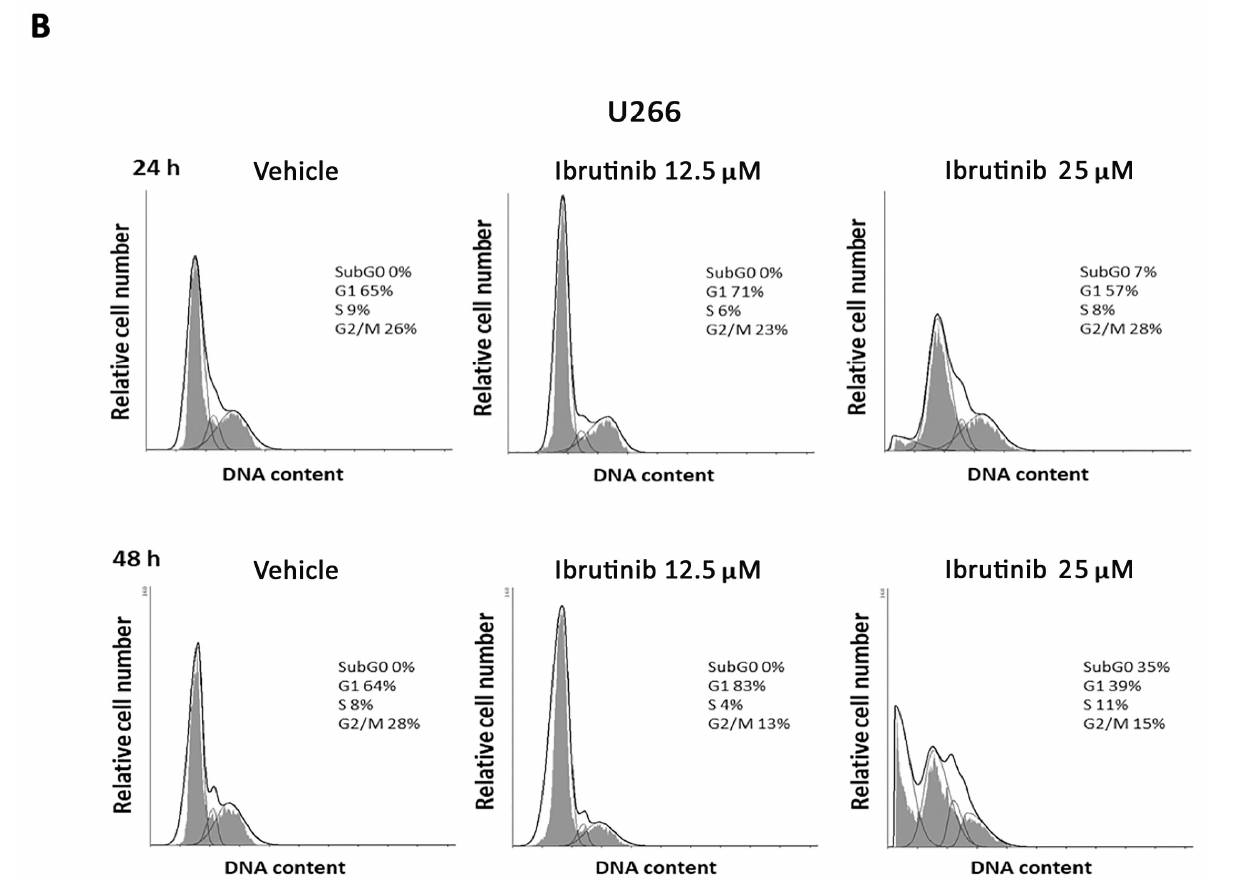
Figure 2. Representative cell cycle distribution in MM cells. ( A ) RPMI and ( B ) U266 cell lines were treated for 24 and 48 h with Ibrutinib. Data are one out of three separate experiments. Data are expressed as percentage of cells in each cell cycle phase .